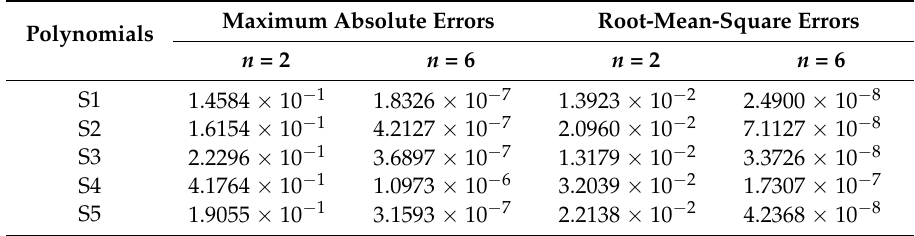
Table 1. Result comparison of Example 1 for different orthogonal polynomials at different values of n . Maximum Absolute Polynomials